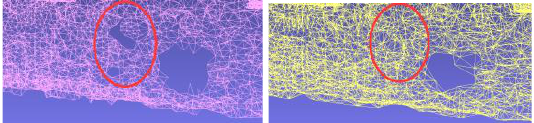
Figure 19 . Detail of the model before and after optimization (left is before optimization, right is after optimization)